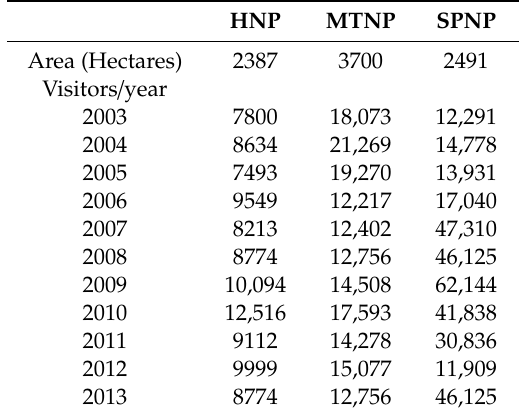
Table 1. Area (Ha) and number of visitors to natural parks in southern Alicante. HNP MTNP SPNP Area